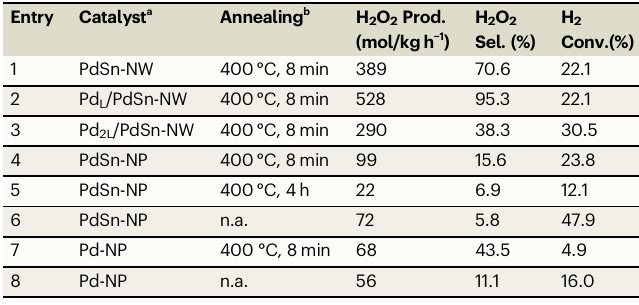
Table 1 | Catalytic performances of various Pd catalysts sup- ported on TiO 2 after pretreating under different conditions in the direct synthesis of H 2 O 2 from H 2 and O